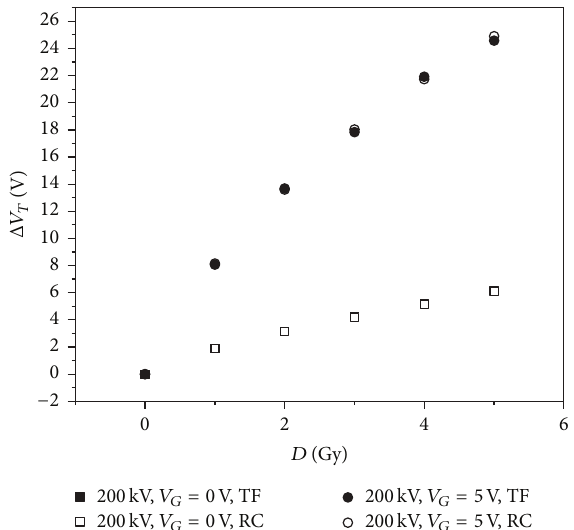
Figure 4: Extrapolated (TF) and reader circuit (RC) Δ𝑉 𝑇 during 280 kV X-ray irradiation with zero and +5V gate bias.